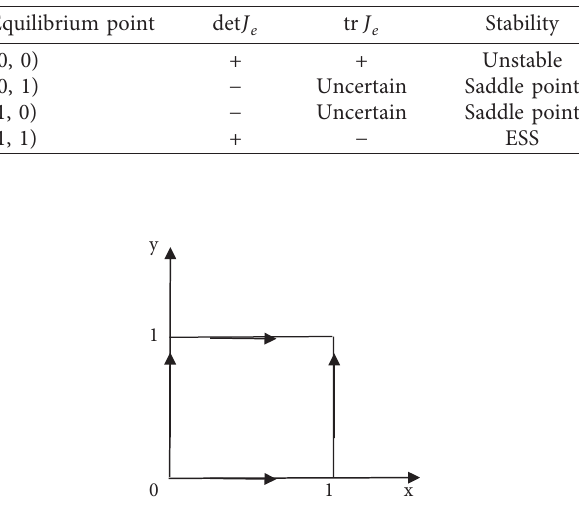
Figure 7: Game phase diagram when μ < ηβ < α and ε < ηβ − α <